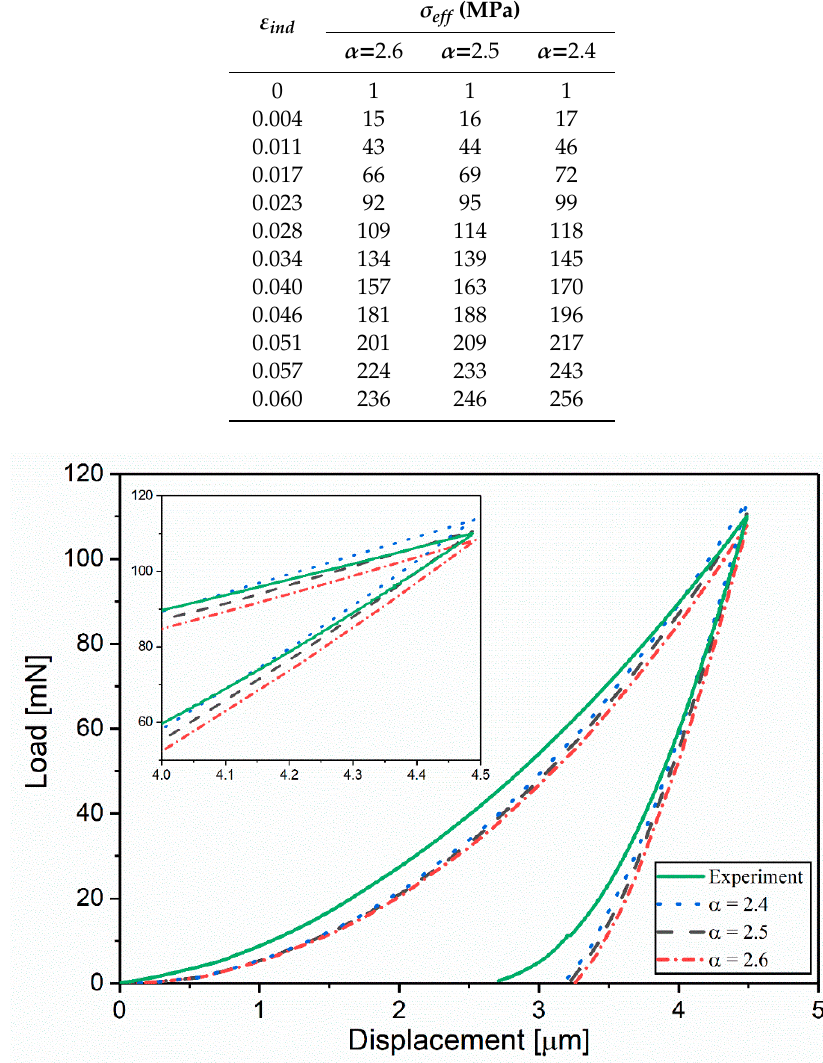
Figure 2. Loading–unloading curves with h = 5 µ m from experiment and ABAQUS with di ff erent α .